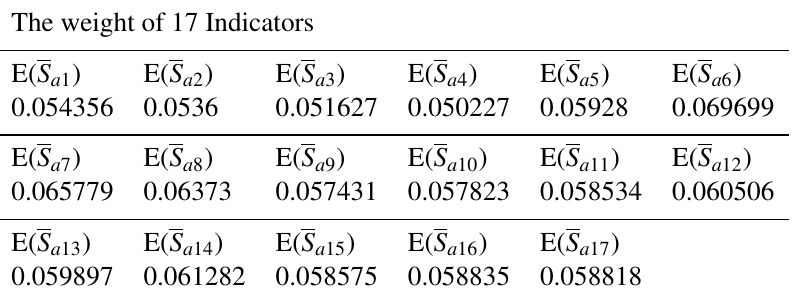
Table 5 Weights of indicators in the cross-cultural competence evaluation